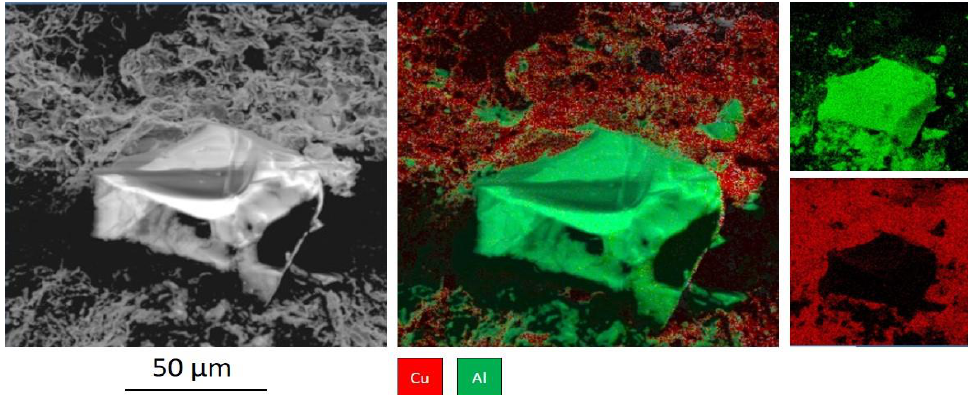
Figure 13. Coarse alumina particle on the separation surface of the cold-sprayed 40% Cu-50% Al 2 O 3 10% Zn coating and distribution maps of elements.